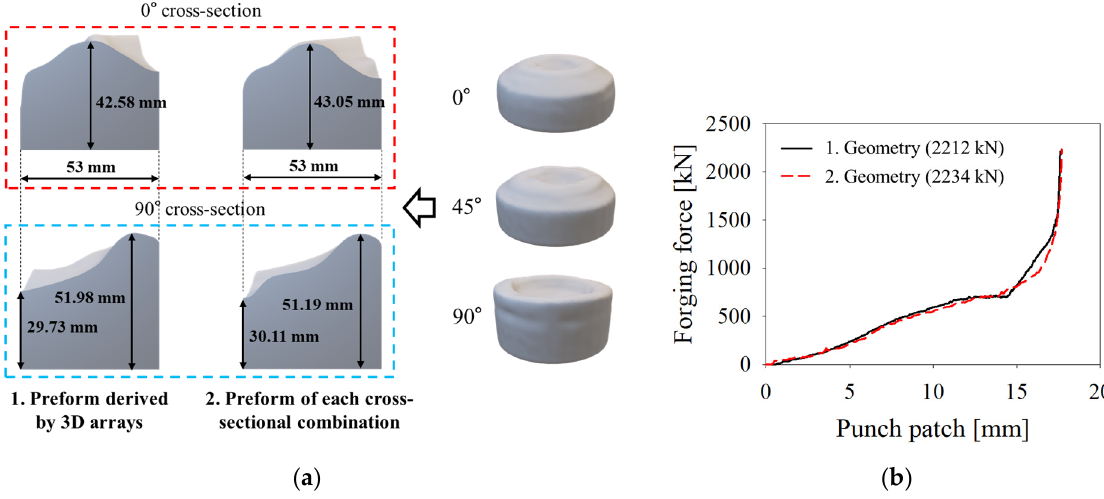
Figure 13. ( a ) Preform shapes derived by CNN#2 for a 3D model inputted at once and the case of combining the 0°, 45°, and 90° shapes and ( b ) Forging force vs. punch patch comparison for two preforms.